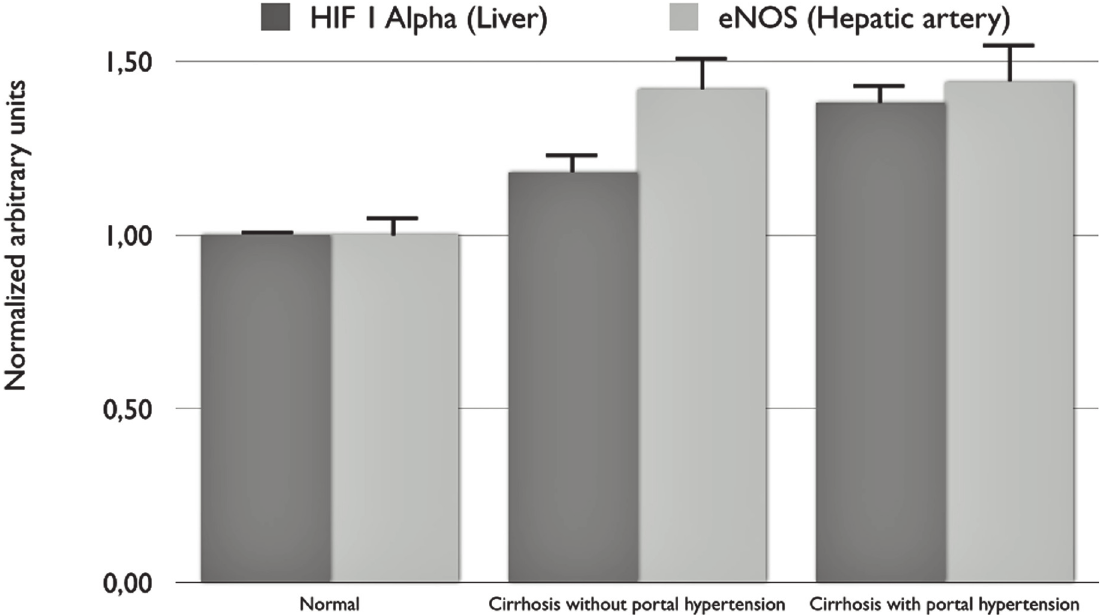
Fig 3. Dose-response curves of methoxamine infusion in the hepatic artery of the portal vein resistance and the sinusoidal vascular resistance in absence (top) or presence (bottom) of L-NMMA. Portal vein and sinusoidal resistance was significantly higher in 12 weeks treated animals compared to normal (PVR: p = 0.0019; SVR: p = 0.007) and 8 weeks (PVR: p = 0.031; SVR not significant different: p = 0.071) treated rats. In presence of L-NMMA only the sinusoidal vascular resistance was different between rats with elevated portal vascular resistance compared to normal (p = 0.003) but not different to the normal portal vascular resistance group (p =